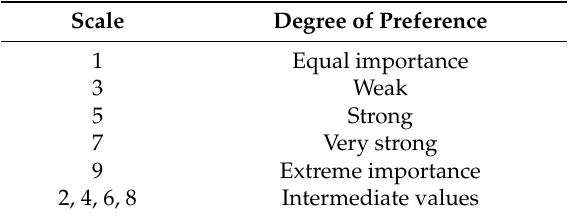
Table 6. Scoring scale of AHP and its interpretation [12].